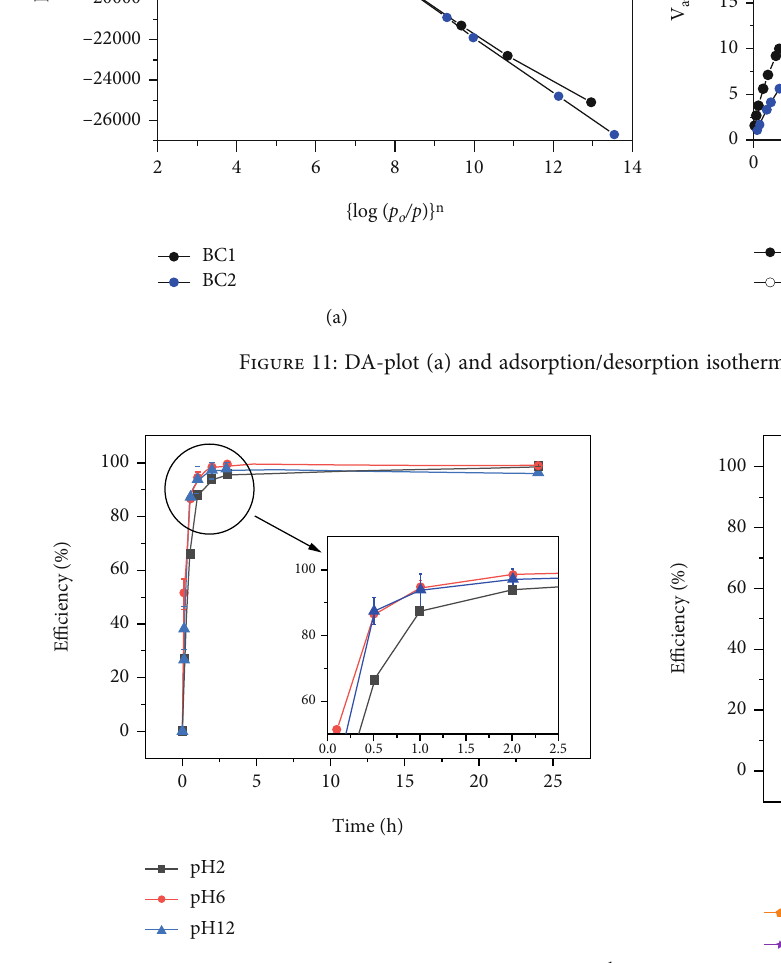
Figure 12: Evaluation of the e ff ect of pH on biochar 1 (5 g.L -1 ) adsorbability of methylene blue ions.